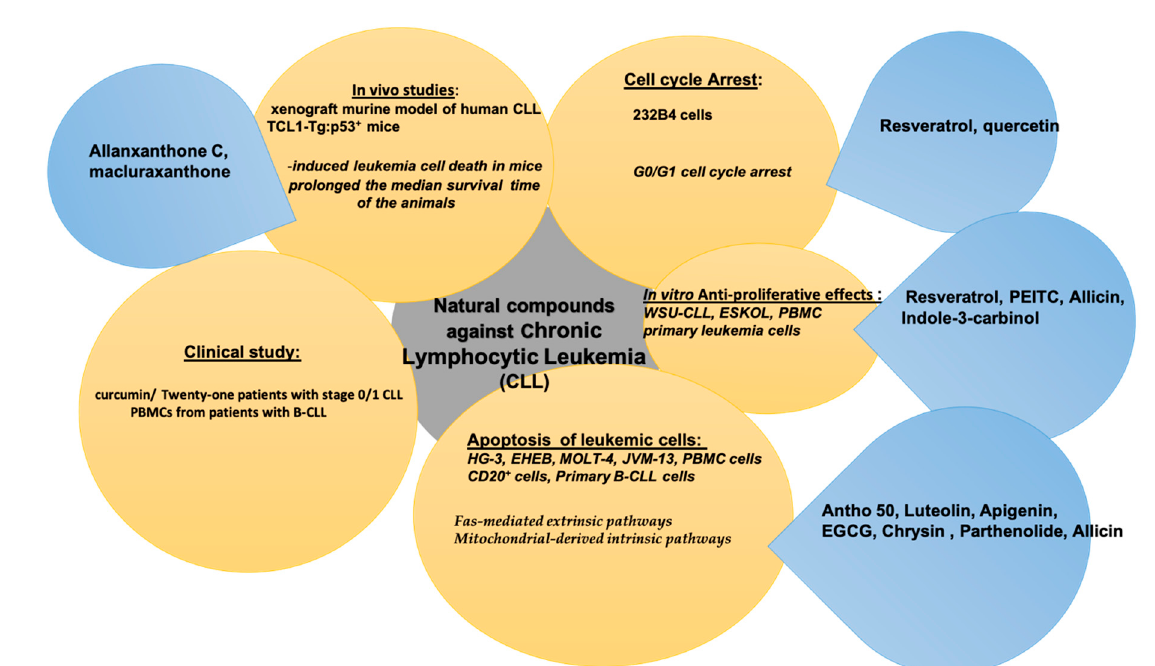
Figure 4. Natural compounds against chronic lymphocytic leukemia (CLL).